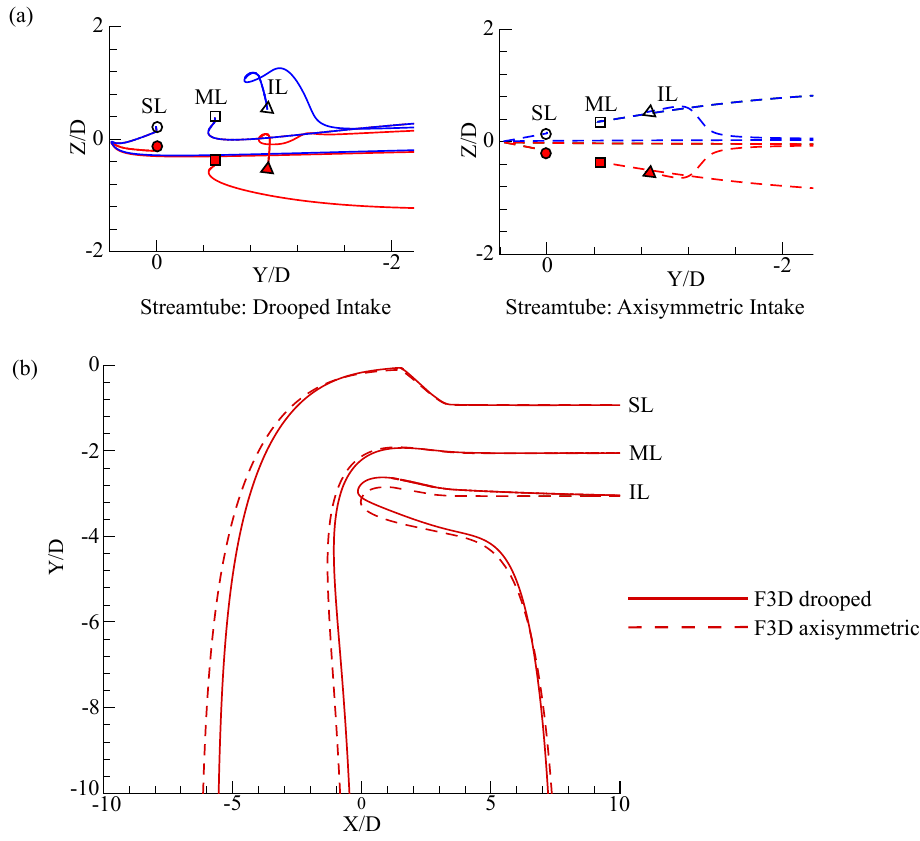
Figure 10. F3D captured streamtubes for (cid:101) ˙ m = 1 obtained from F3D drooped and axisymmetric simulations ( a ) in the Y − Z plane; ( b ) in the X − Y